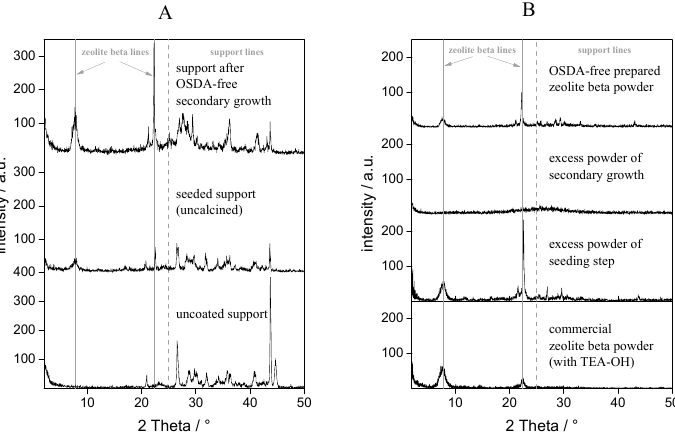
Figure 1. XRD patterns of ‘uncoated support’ (TiO 2 covered stainless steel), ‘seeded support’ (in situ seeded: membrane number 2.1) and ’OSDA-free secondary growth’ (membrane number 2.2) for experimental series 2 ( A ). In addition, the related excess powders as well as a beta powder prepared without an OSDA and commercial zeolite beta powder prepared with TEAOH for comparison ( B